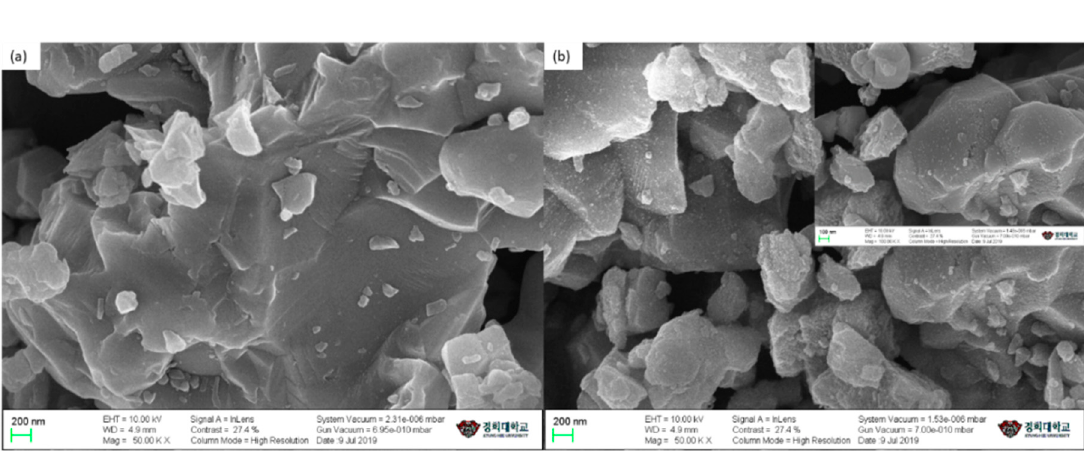
Figure 3. FE-SEM images of ( a ) non-treated AlN and ( b ) Si–AlN (Inset: 100 KX).